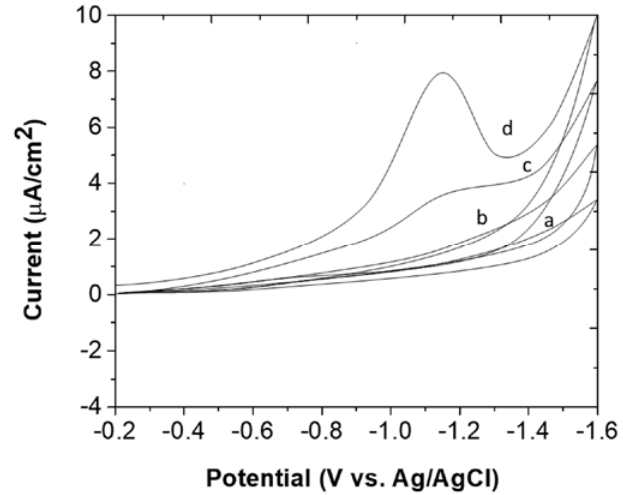
Fig. 5. Cyclic voltammograms for butachlor (6.0 µg ⸳ mL -1 ) at bare GCE (a), MWCNTs/GCE (b), Pd/GCE (c) and Pd@MWCNTs/GCE (d) in pH 6.0 (0.10 M of phosphate buffer); accumulation potential –1.13 V; accumulation time 80 s; pulse amplitude 30 mV; scan rate 50 mVs -1